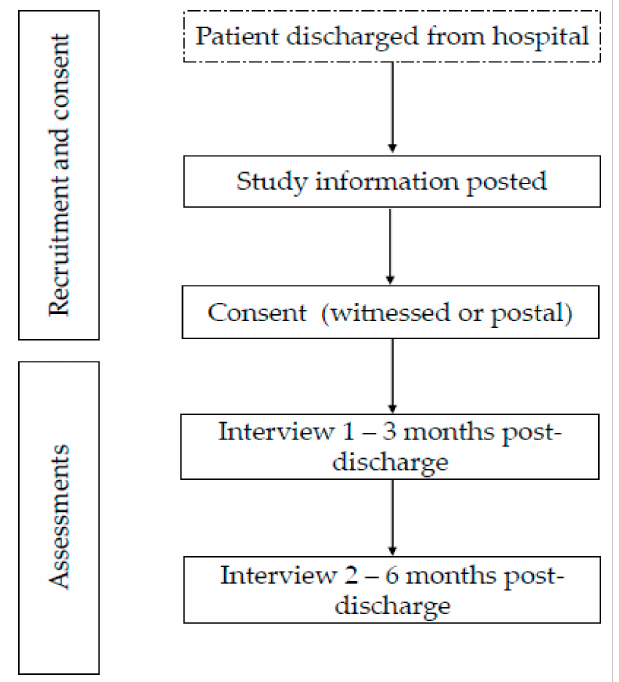
Figure 1. Recruitment and Data collection